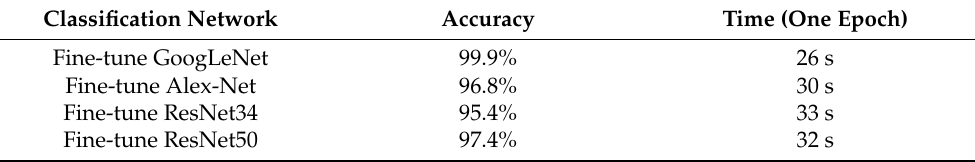
Table 7. Comparison of experimental results of different classification network models.